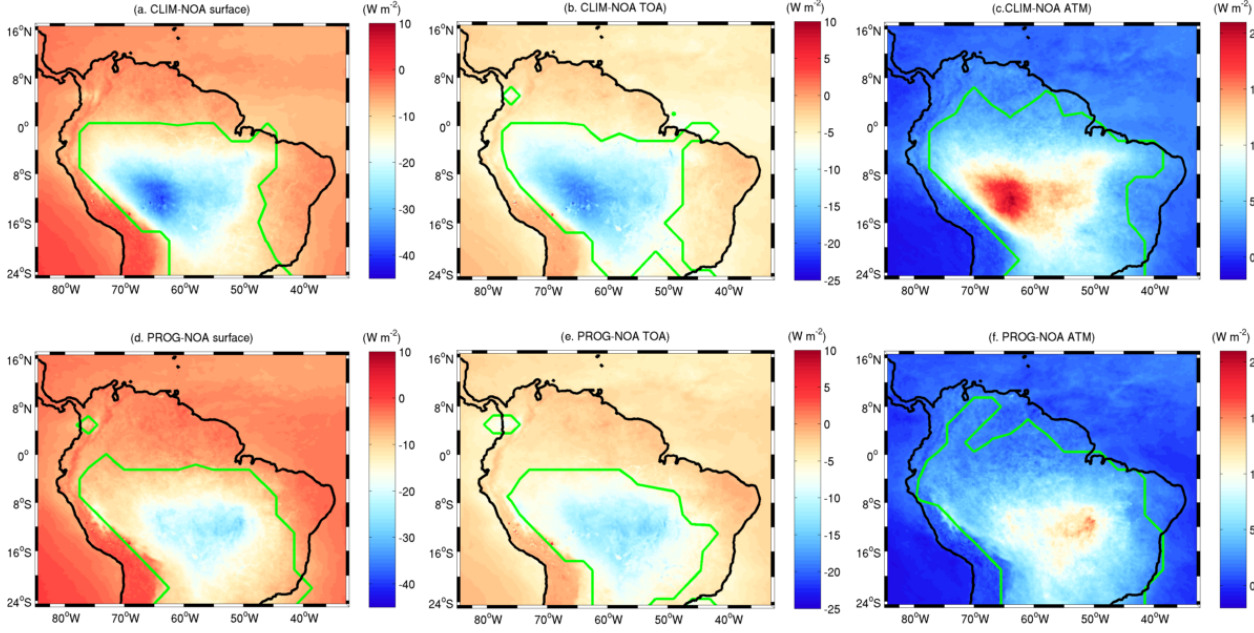
Figure 4. Impact of (top row) CLIM and (bottom row) PROG aerosol representations on (a, d) the net surface radiation, (b, e) net TOA radiation and (c, f) net atmospheric divergence averaged over the whole SAMBBA period for clear skies. Green contour shows where BBA impacts are greater than the standard